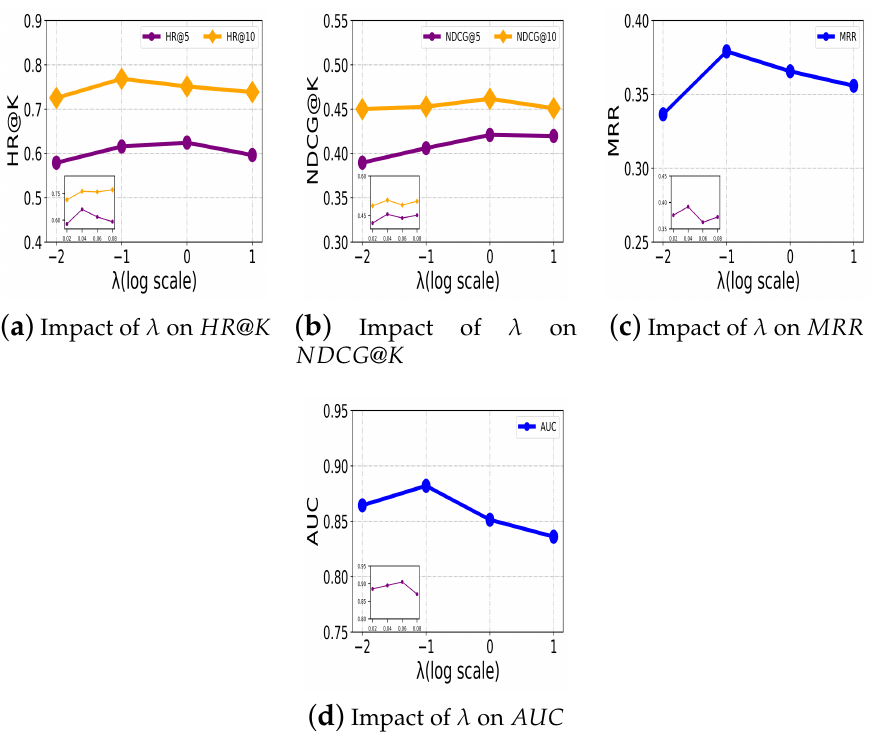
Figure 9. Parameter sensitivity of AGMKRec over regularization rate λ .